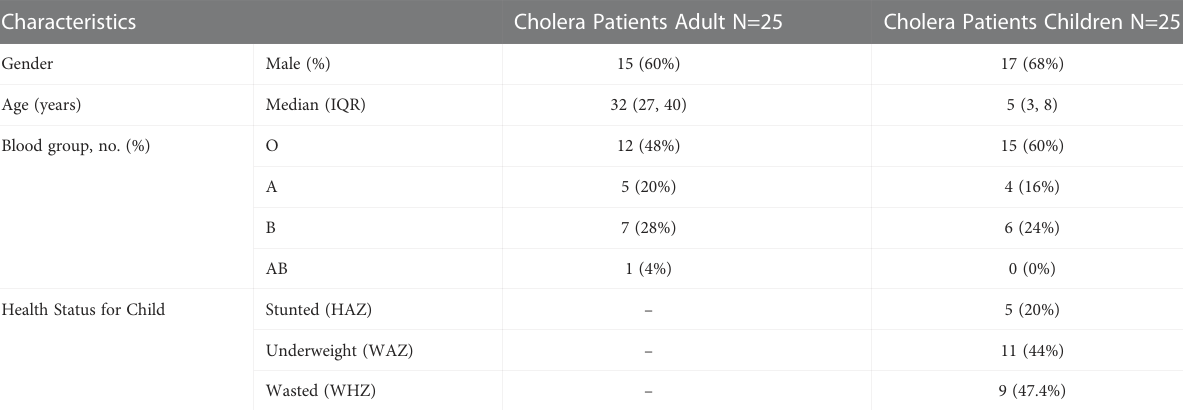
TABLE 1 Demographic and anthropometric characteristics of the participants enrolled in the study.